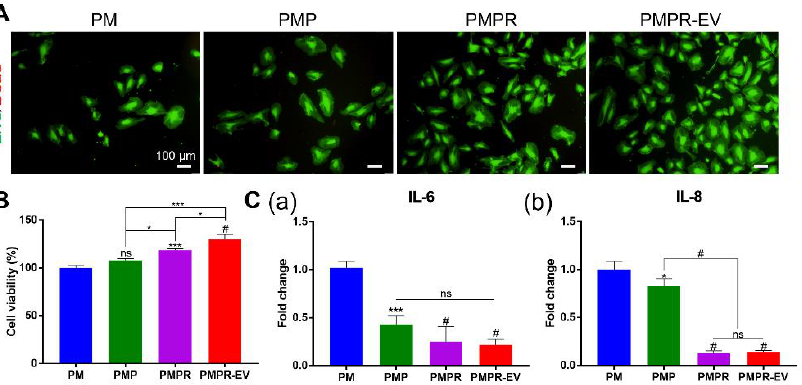
Figure 4. ( A ) Live-Dead assay images and ( B ) cell viability of HUVECs onto the composites at 24 h. ( C ) Gene expressions of IL-6 ( a ) and IL-8 ( b ) for the anti-inflammatory effect in HUVECs onto the composites. * p < 0.05, *** p < 0.001, and # p < 0.0001 indicate statistically significant differences,